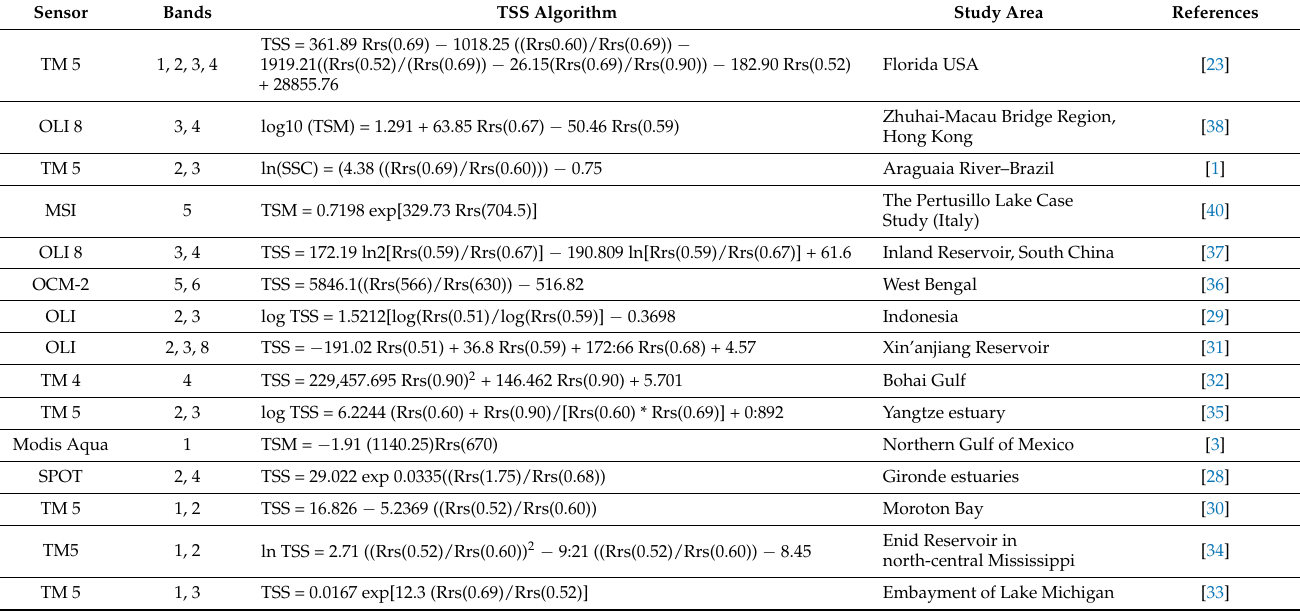
Table 1. Review of previous TSS algorithms. For TM 4 and TM 5, the wavelength of B1,B2,B3 and B4 are 0.45–0.52, 0.52–0.60, 0.63–0.69, 0.76–0.90 µ m, respectively. For Landsat 8, the wavelength for B2,B3,B4 and B8 are 0.45–0.51, 0.53–0.59, 0.64–0.67, 0.50–0.68 µ m, respectively. For MSI (MultiSpectral Instrument), the wavelength for B5 is 704.5 nm. For OCM-2, the wavelength for B5 and B6 are 546–566 and 610–630 nm, respectively. For MODIS Aqua, the wavelength for B1 is 620–670 µ m. For SPOT, the wavelengths for B2 and B4 are 0.61–0.68, 1.58–1.75 µ m. Sensor TSS